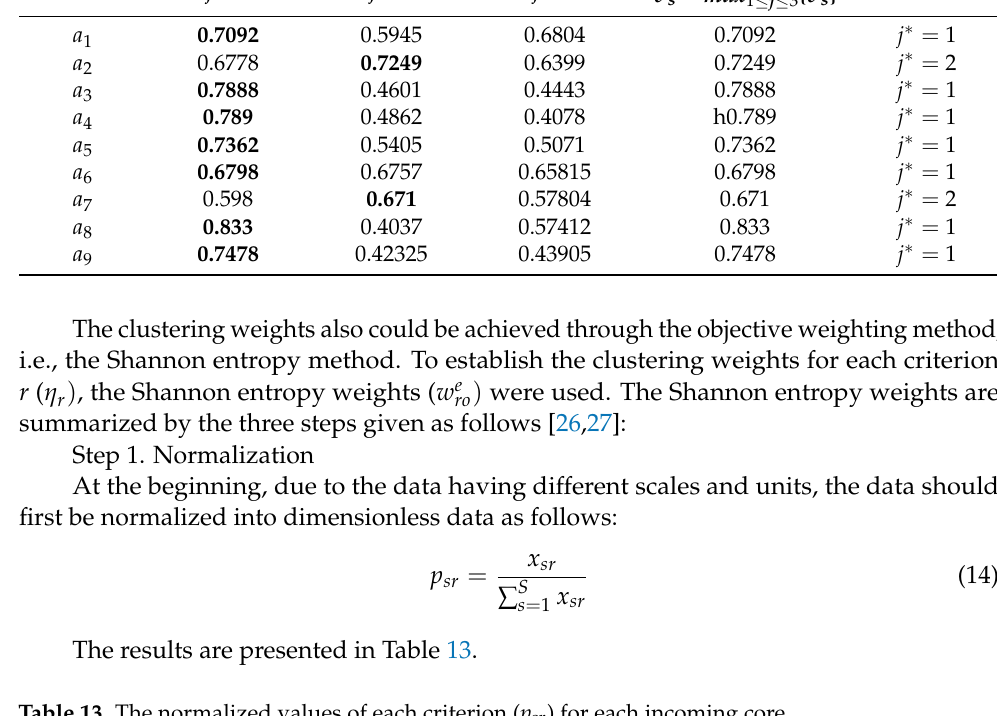
Table 13. The normalized values of each criterion ( p sr ) for each incoming core. Core ( a s